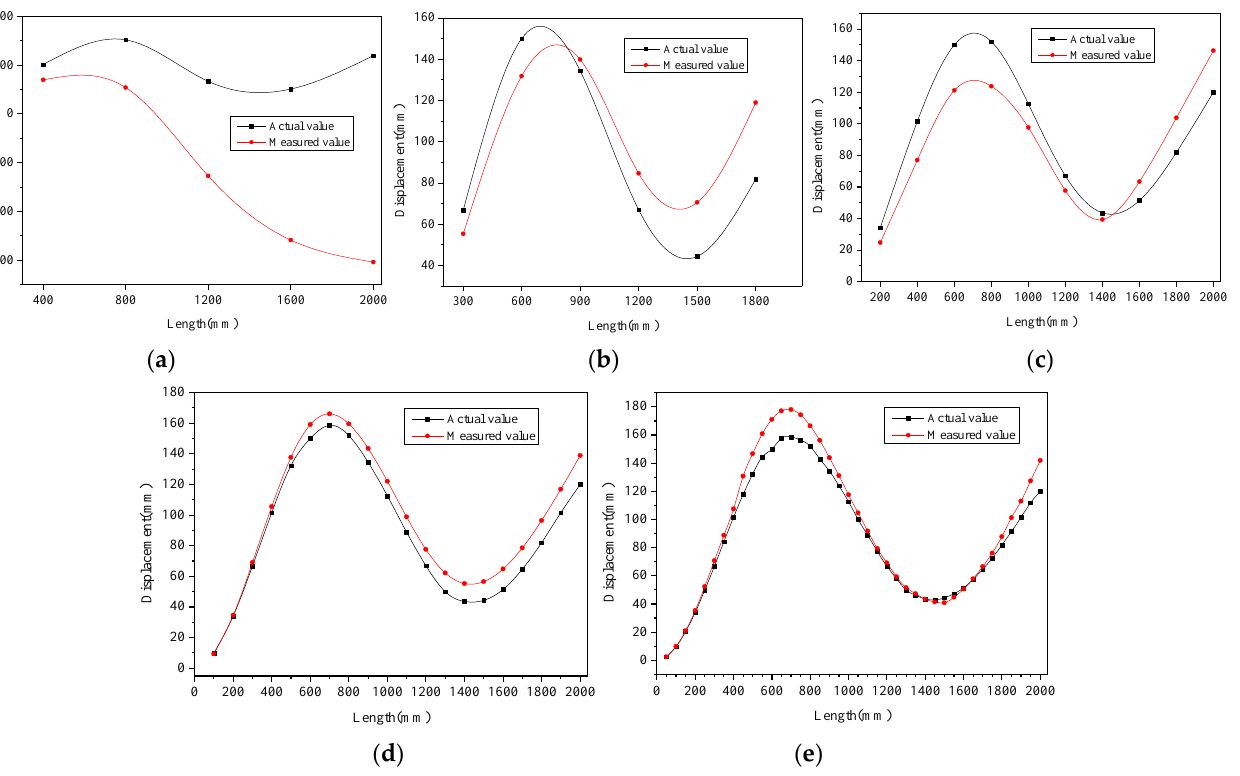
Figure 16. Comparison between calculated displacement and measured displacement of measuring points at different intervals: ( a ) l = 400 mm; ( b ) l = 300 mm; ( c ) l = 200 mm; ( d ) l = 100 mm; ( e ) l = 50 mm.